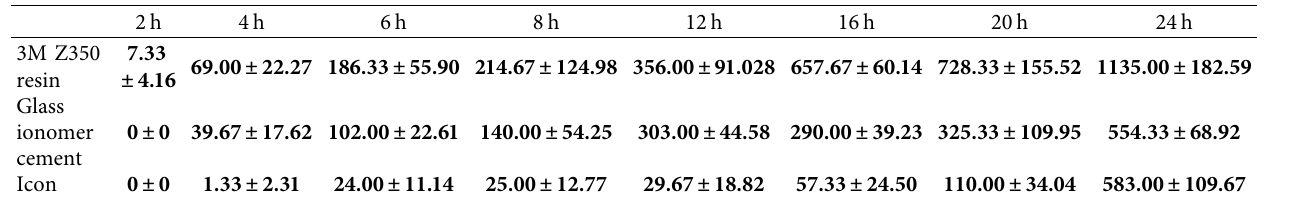
Table 6: Actinomyces viscosus group (electron microscopy counting).